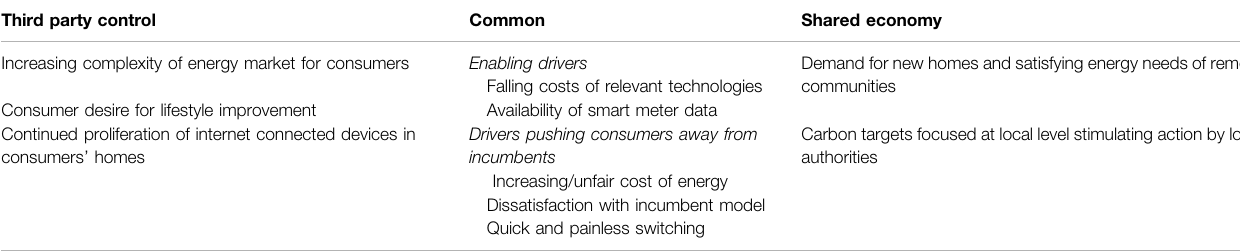
TABLE 2 | Drivers for business